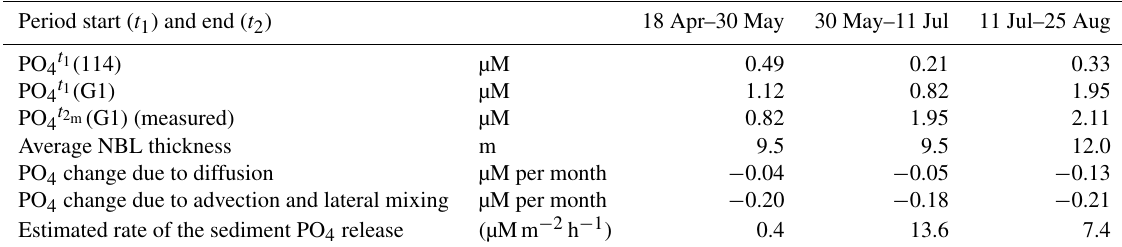
Table 3. Estimated changes in NBL phosphate concentration due to advection and diffusion and estimated sediment release of phosphates in the Gulf of Riga between the monitoring campaigns in